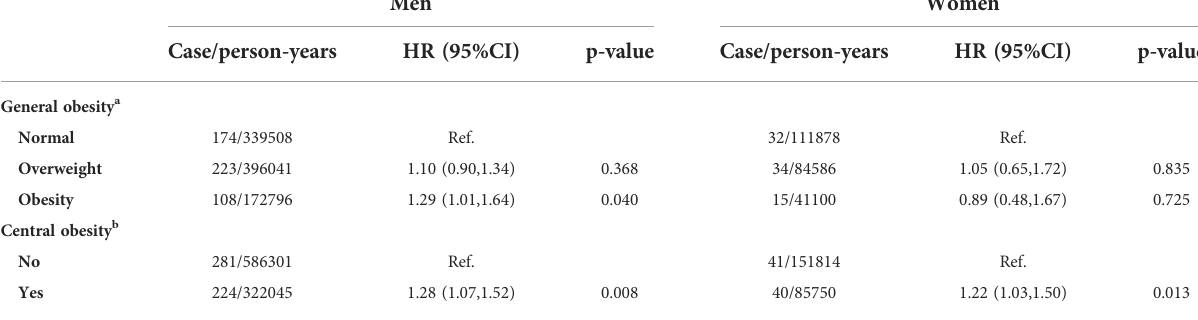
TABLE 2 The association of general obesity or central obesity with CRC risk.